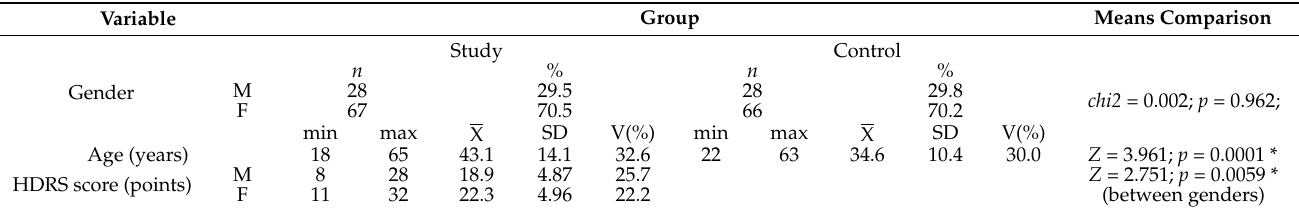
Table 1. The characteristics of the studied